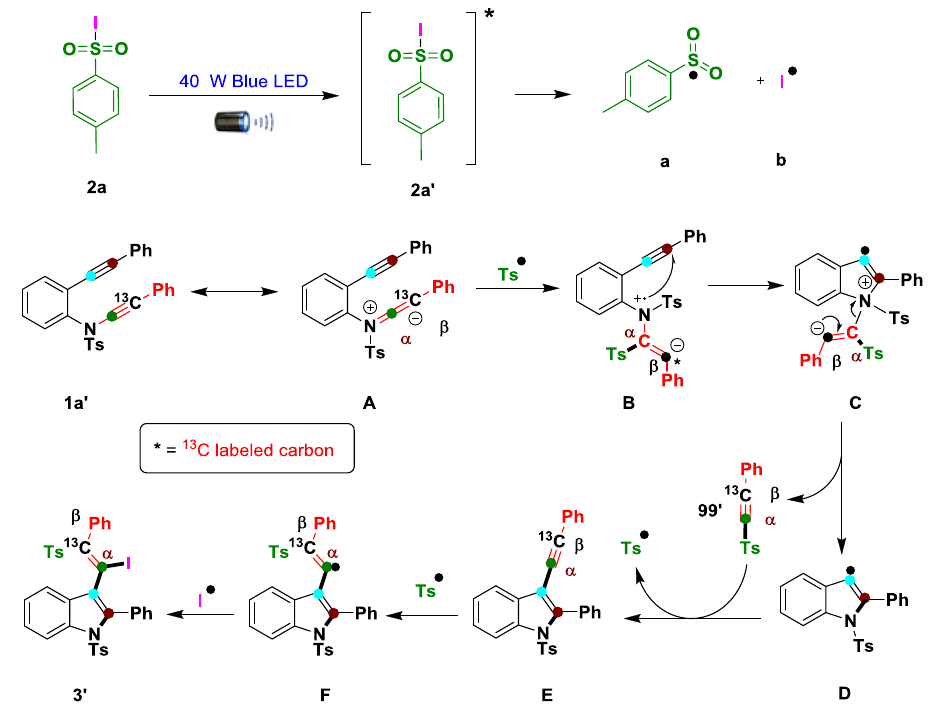
Fig. 9 Plausible reaction mechanism. Blue LED light initiated ynamide C( sp ) – N bond clevage, intramolecular alkyne reshuf fl ing and